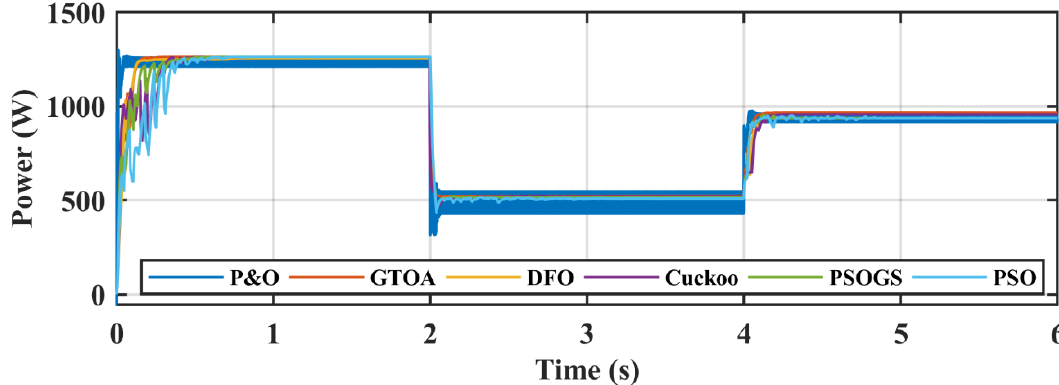
Figure 9. Comparison of power of GTOA. Dragon fly optimization (DFO), particle swarm optimization (PSO), perturb and observe (P&O), and particle swarm optimization gravitational search (PSOGS).